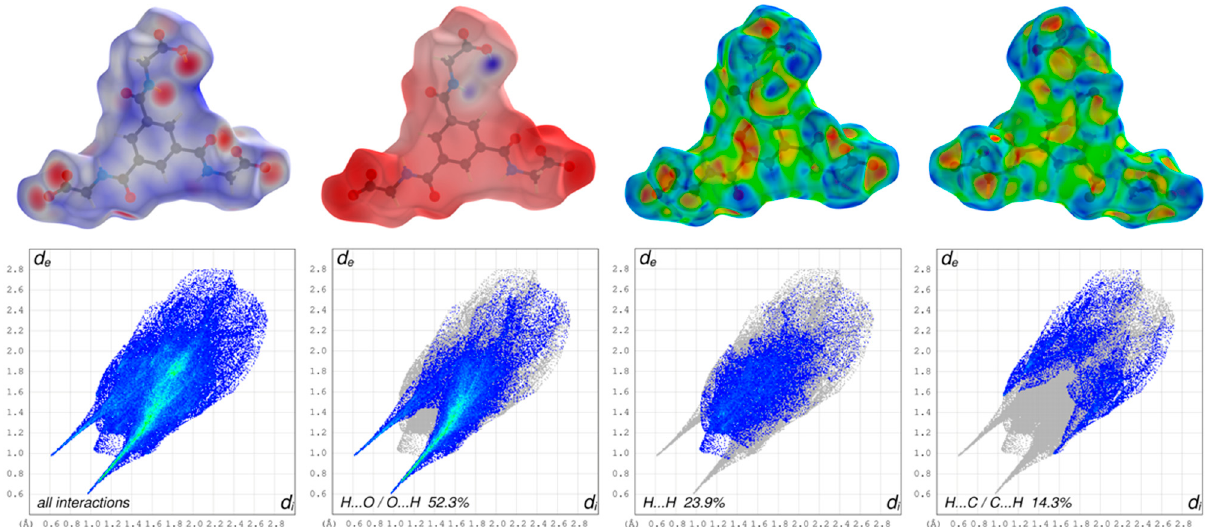
Figure 5. Graphical representations of the Hirshfeld surfaces of the dianion drawn with transparency and mapped over the d norm , the electrostatic potential energy and the shape-index of both sides of the anion (upper part; from left to right) and the assosiated two-dimensional fingerprint plots of all and main interactions (lower part).